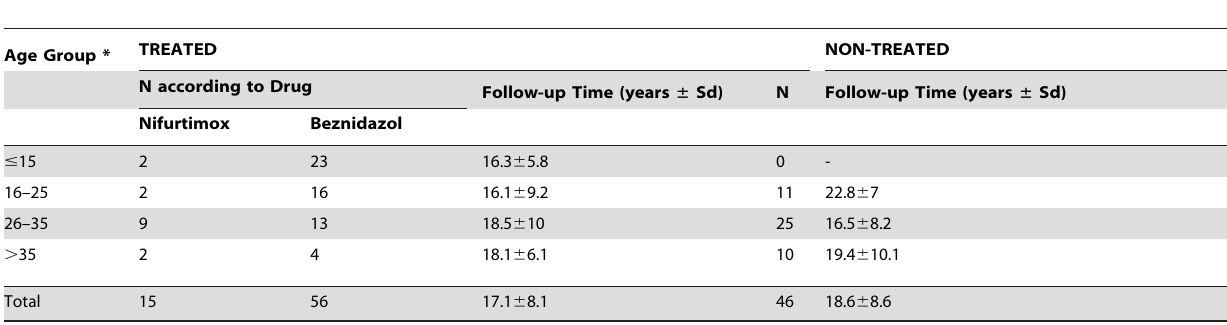
Table 3. Distribution of 117 women with chronic infection of T. cruzi, treated and untreated with nifurtimox or benznidazole, by age group and time of follow-up equal to or greater than 8 years, Argentina.